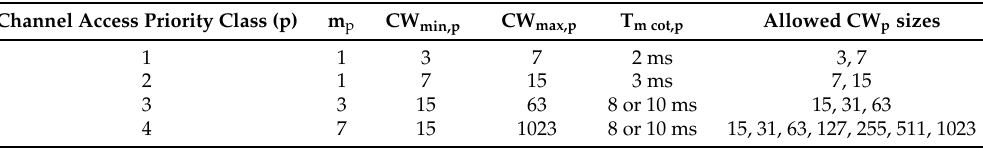
Table 2. LTE LAA channel access priority